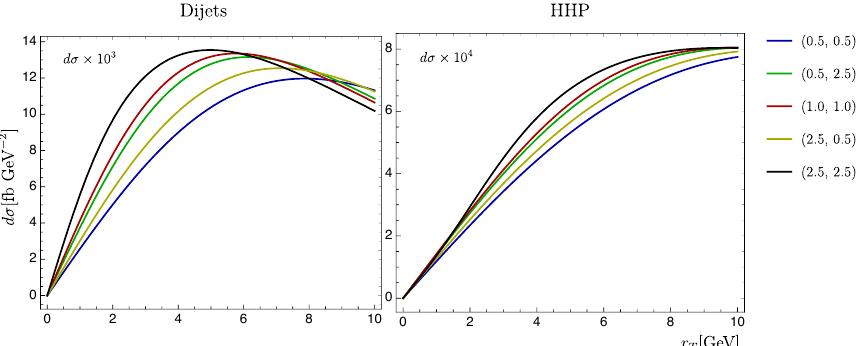
Figure 2. Impact of B NP variation over dijets and heavy meson total cross-section. Legend correspond to ( B S ) and ( B S ) for dijet and HHP production respectively , B C , B J NP NP NP NP